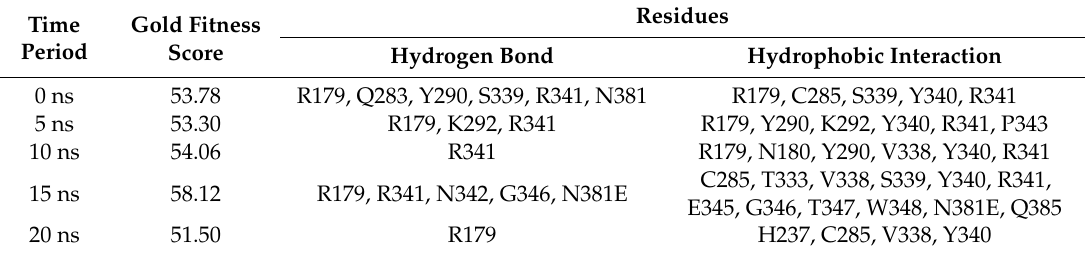
Table 3. E ffi cacy of ZINC19370490 against caspase 8 at di ff erent time intervals and the active site residues involved in the binding.